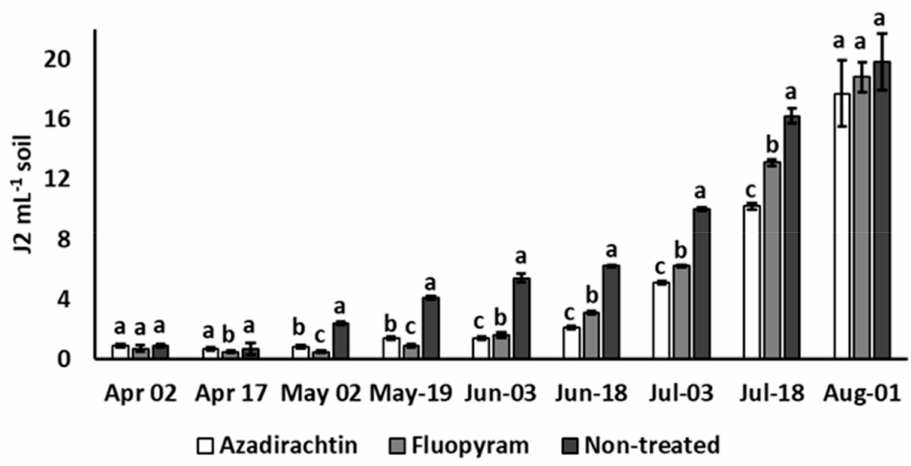
Figure 1. Effect of soil treatments with azadirachtin and fluopyram on soil population density of Meloidogyne incognita along the tomato crop cycle. Bars marked by the same letters at each sampling date are not significantly different, according to the Student–Newman–Keuls test ( p > 0.05).